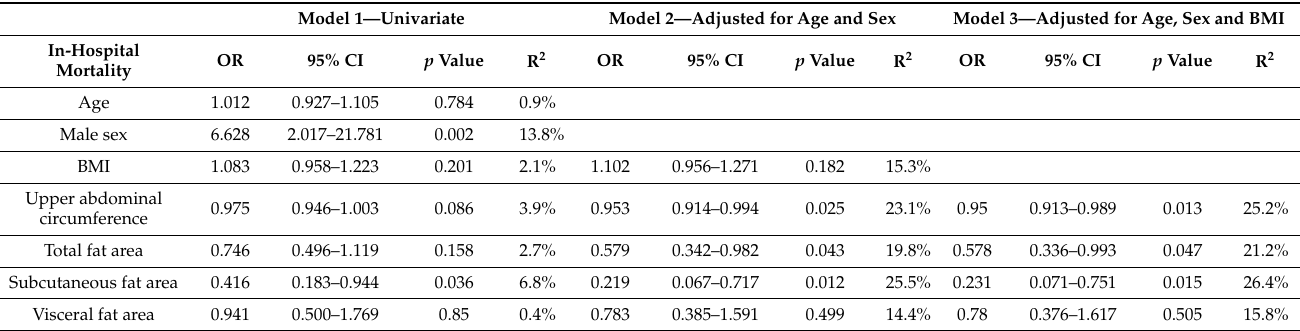
Table 3. Univariate and multiple logistic regression models for the association of in-hospital mortality. Model 1—Univariate Model 2—Adjusted for Age and Sex Model 3—Adjusted for Age, Sex and